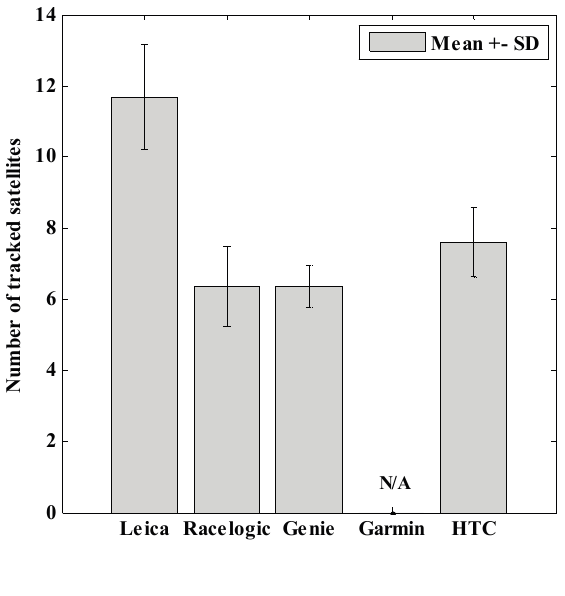
Figure 8. Mean number of tracked satellites (bars) for each GNSS device during the measurements and the corresponding standard deviations (SD) (error bars). Note that the number of tracked satellites for Garmin was not available